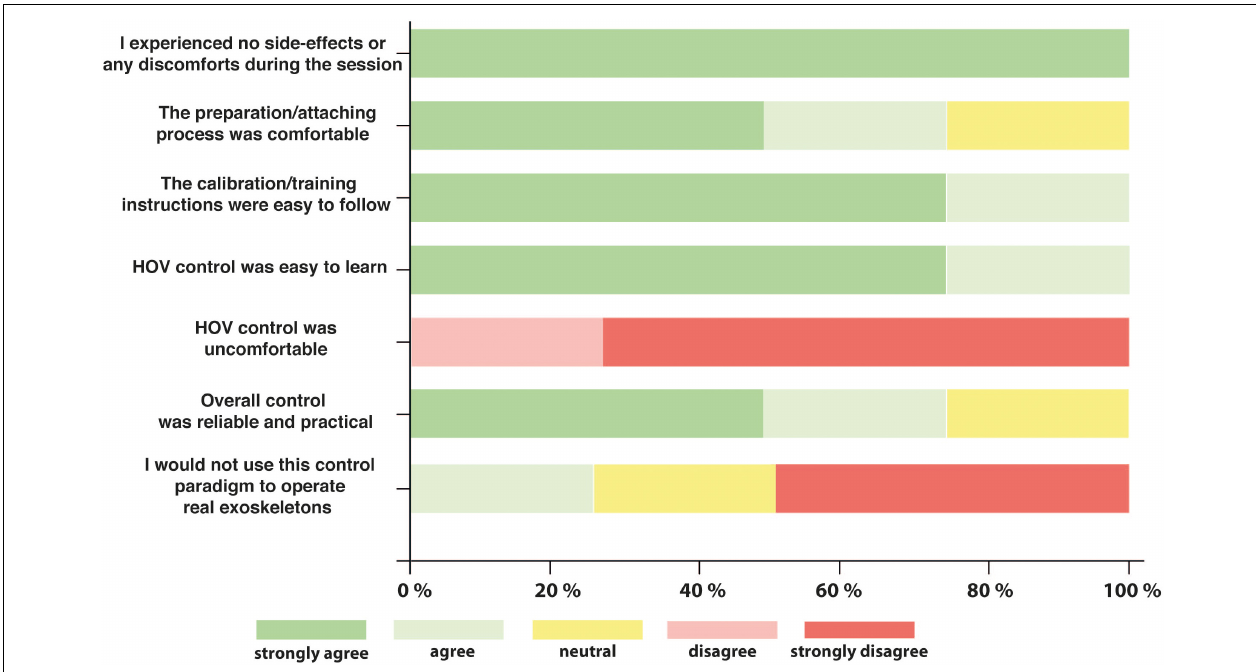
FIGURE 7 | Five-level Likert scale questionnaire. After the experiment, all tetraplegics rated the user-friendliness of the overall process and especially the novel electrooculography (EOG) control commands. Likert scale ranged from 1 to 5 with “1 = strongly agree” and “5 = strongly